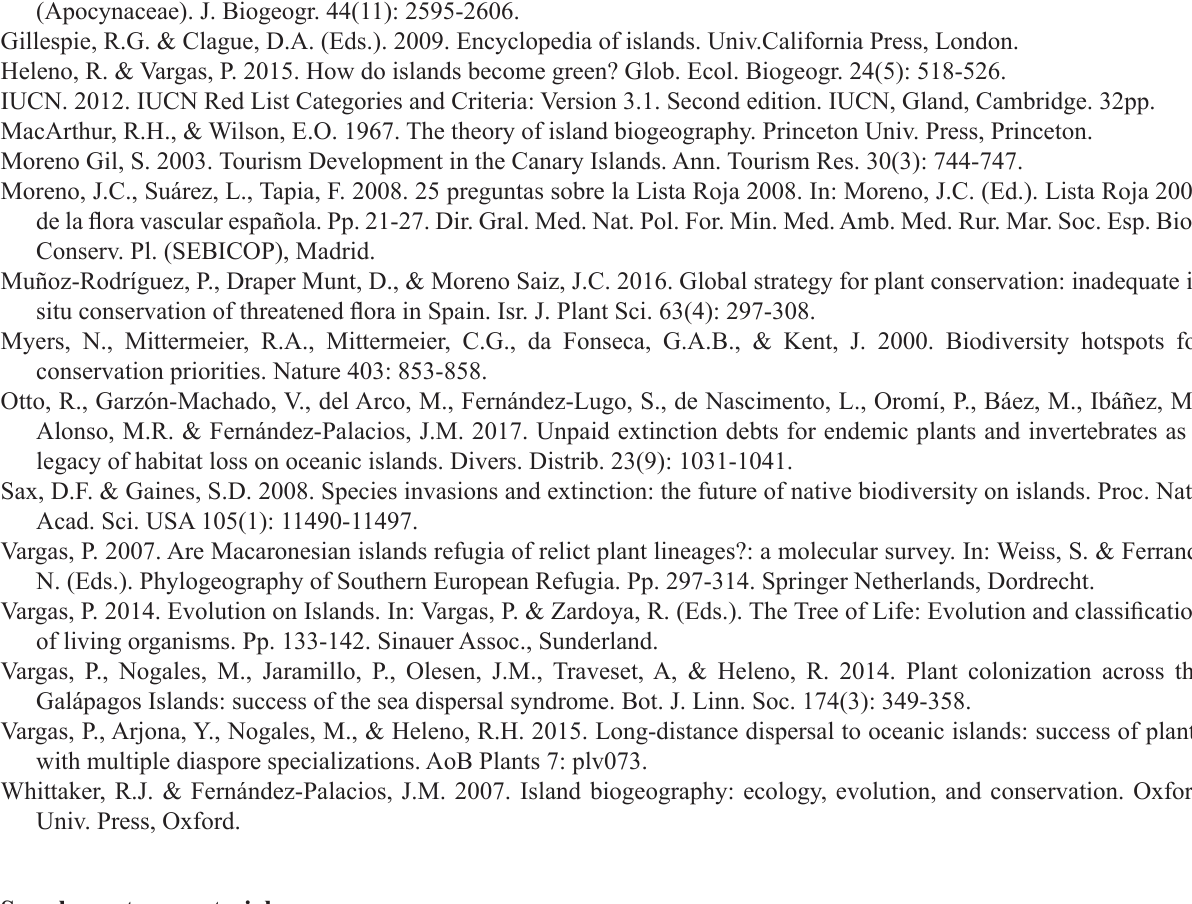
Table S1: Contingency table of number of species of endemic lowland flora of Canary Islands classified as threatened and non-threatened with and without LDD syndromes”. We also corrected the Supplement. Table S2: Contingency table of number of species of endemic lowland flora of Canary Islands classified by IUCN categories and the presence or absence of LDD